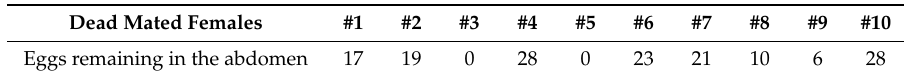
Table 1. Egg production capacity of ten virgin Xylotrechus chinensis females.